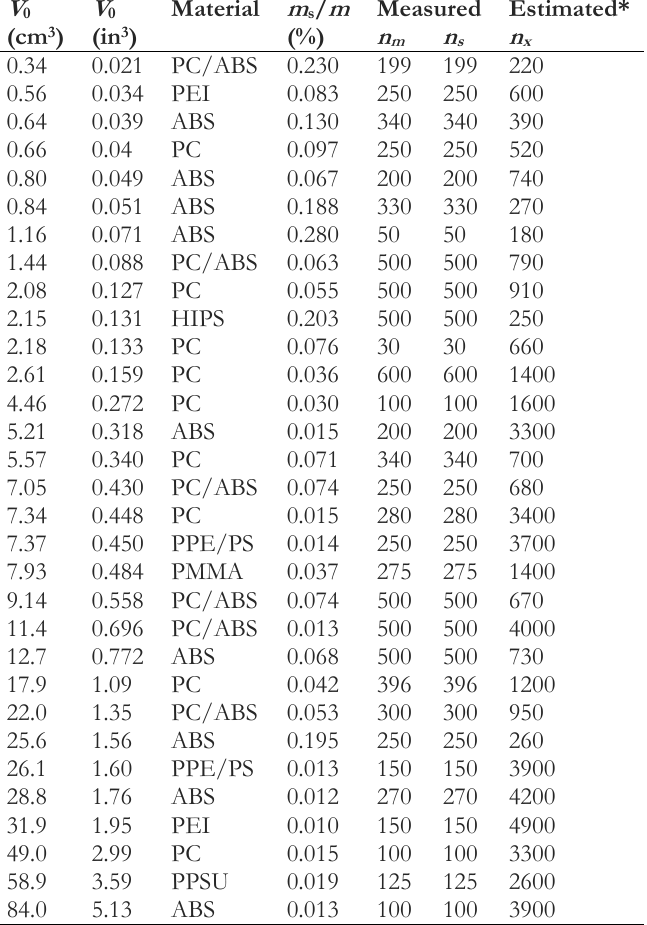
Table 1. Data from counting experiments for parts of various nominal volumes (V 0 ) and